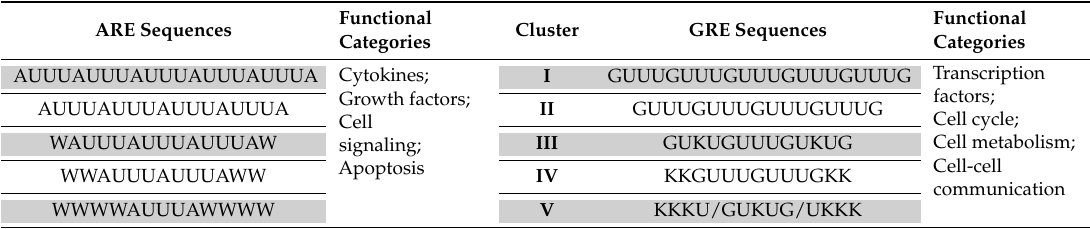
Table 1. Structural and functional classifications of AU-rich elements (AREs) and GU-rich elements (GREs). Functional Cluster GRE Sequences ARE Sequences Categories